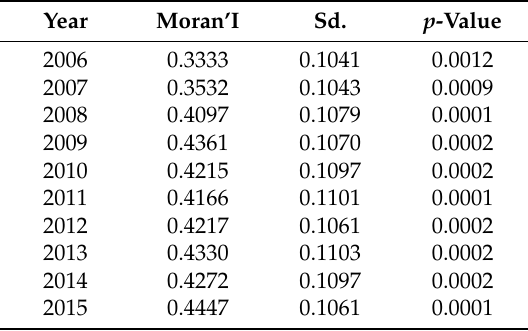
Table 2. Global Moran’s I estimate based on the Monte Carlo test.